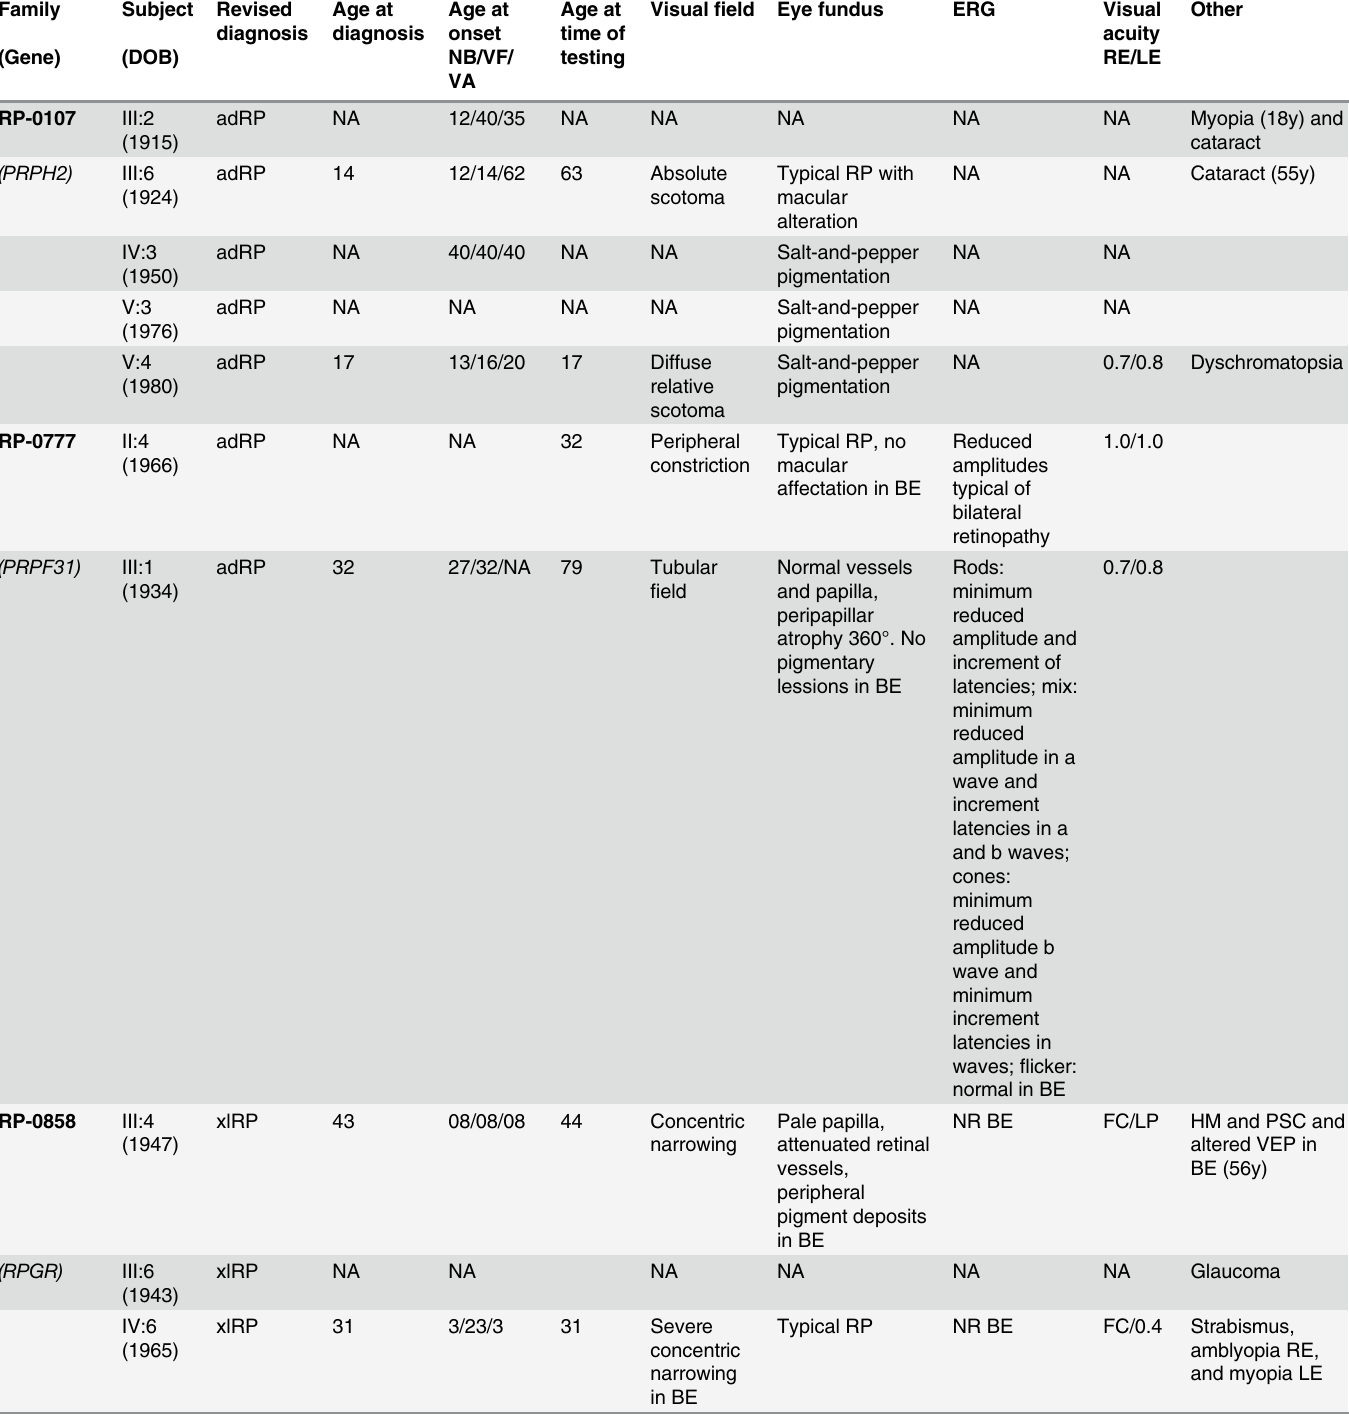
Table 2. Clinical features of the four families genetically characterized in the present study. All the ages are expressed in years. adRP = autosomal dominant retinitis pigmentosa, DOB = date of birth, BE = both eyes, ERG = Electroretinogram, HM = High myopia, LE = left eye, LORD = Late Onset Retinal Dystrophy, LP = Light perception, MA = myopic astigmatism, MD = macular degeneration, MM = myopic maculopathy, NA = not available, NB = night blind- ness, NR = Non recordable, RE = right eye, RP = retinitis pigmentosa; RPE = Retinal pigment epithelium, VA = visual acuity, VEP = visual evoked potentials, VF = visual field, xlRP = X-linked retinitis